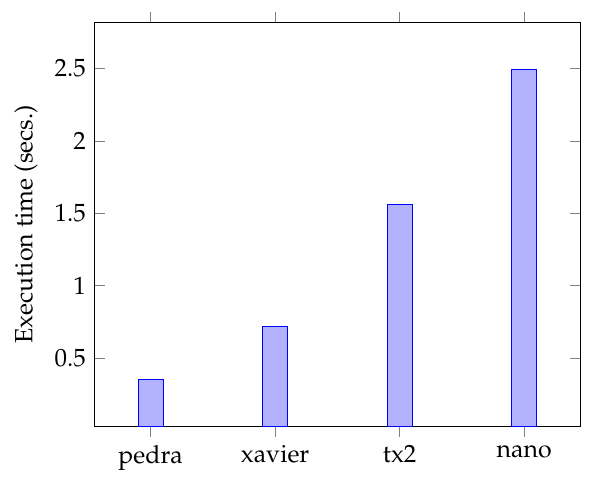
Figure 4. Image preprocessing execution